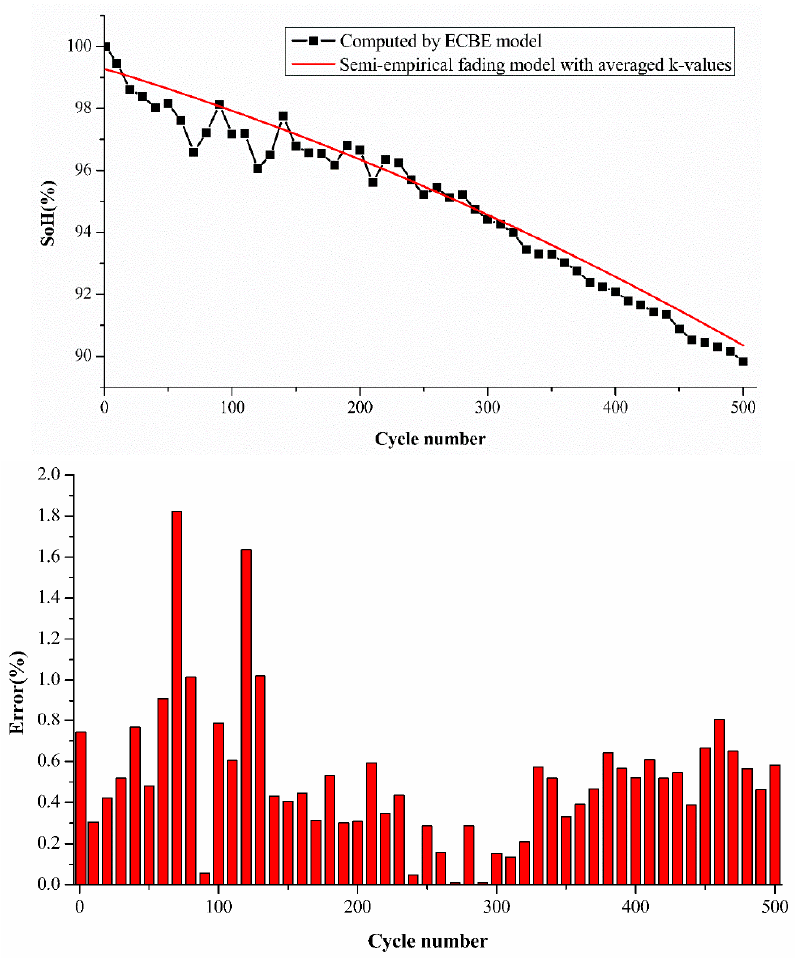
Figure 6. Difference comparison between the battery fade model using average parameters and the ECBE model for cell A2.